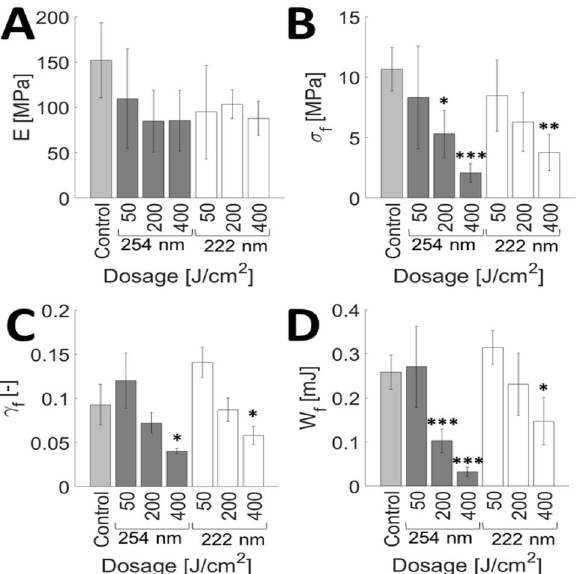
Figure 6. UVC light induces changes in the mechanical properties of SC equilibrated to 25% RH. Average ( A ) elastic modulus, E , ( B ) fracture stress, σ f , ( C ) fracture strain, γ f , and ( D ) work of fracture, W f for unirradiated controls (Control; light grey), 254 nm irradiated samples (dosage range: 50–400 J/cm 2 ; dark grey), and 222 nm irradiated samples (dosage range: 50–400 J/cm 2 ; white). Bars denote average values of 4 ≤ n ≤ 5 individual sample measurements for each range and dosage condition. Error bars denote standard deviations. Confidence intervals are indicated by * p ≤ 0.05, ** p ≤ 0.01, *** p ≤